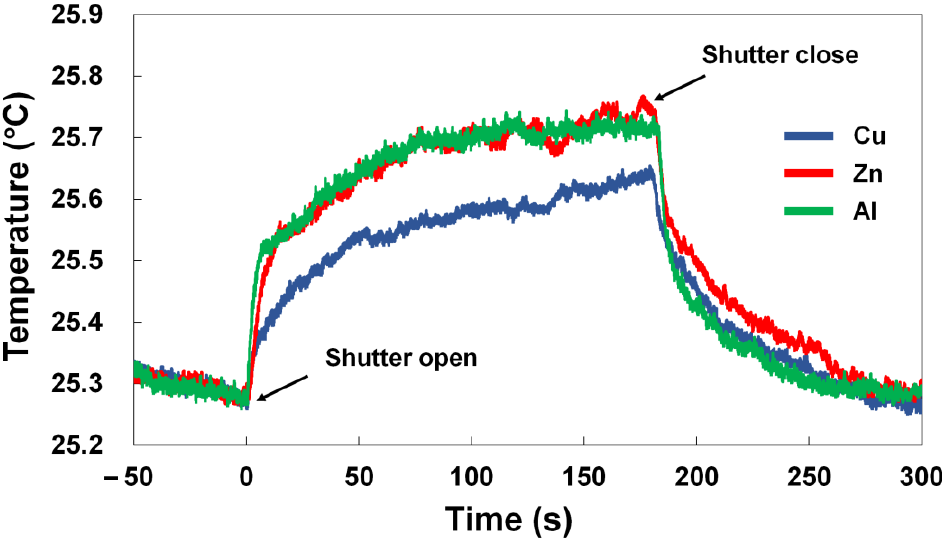
Figure 3. Temperature measurement in the vicinity of the X-ray interaction point on Zn, Cu and Al plates.